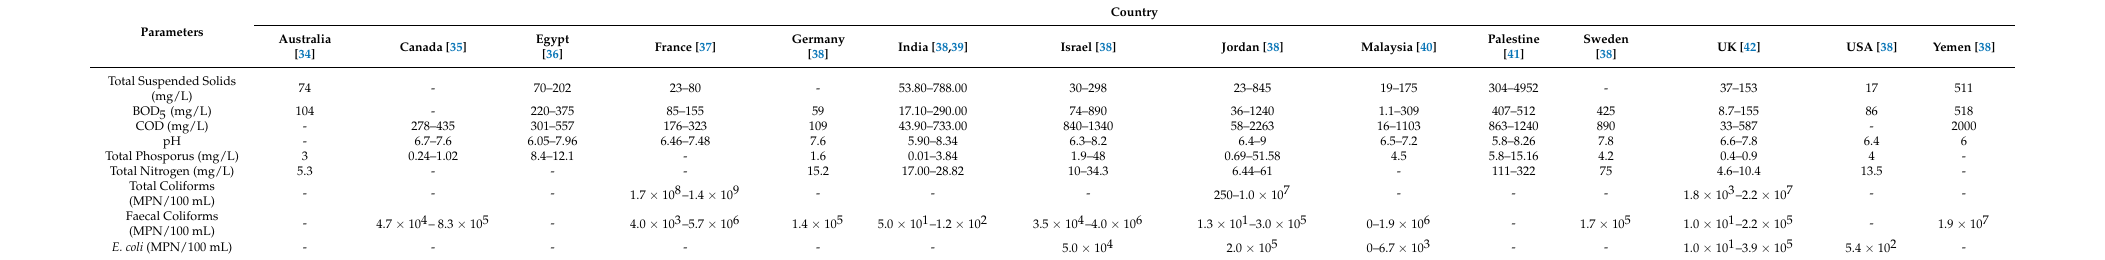
Table 3. Range/average of physical and chemical parameters of domestic greywater in several